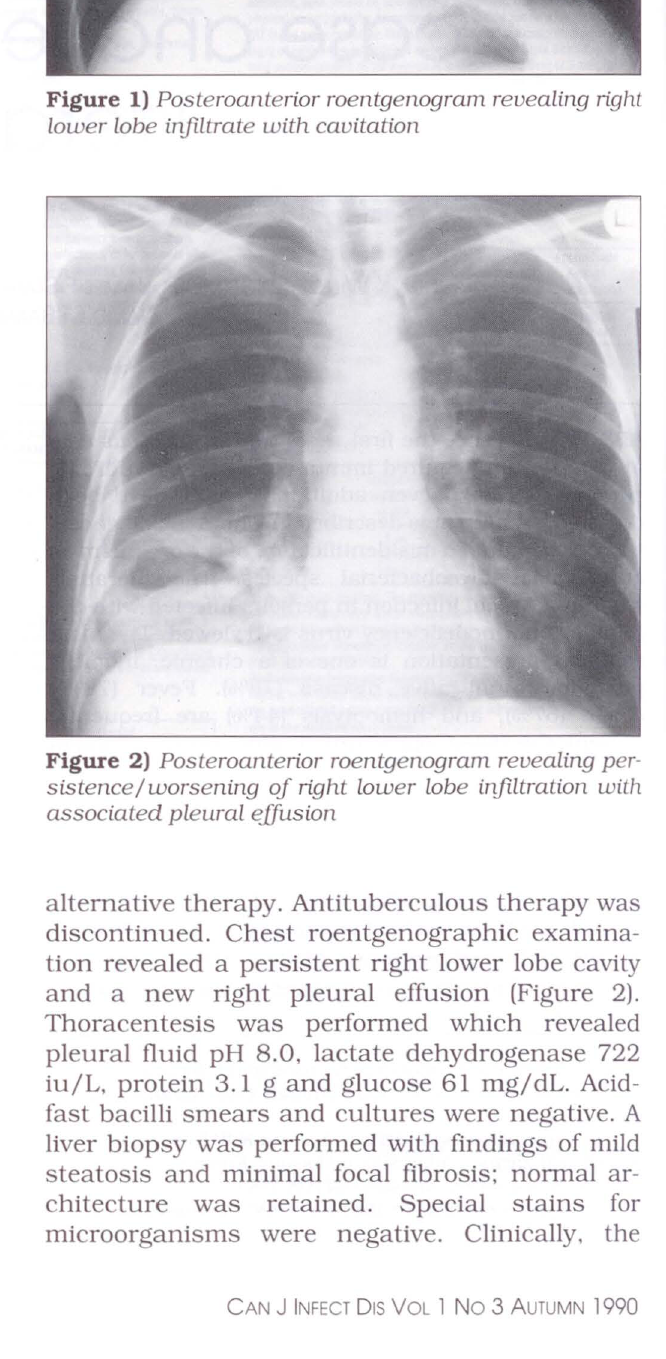
Figure 1) Posteroanterior roentgenogram revealing right lower lobe infiltrate with cavitation